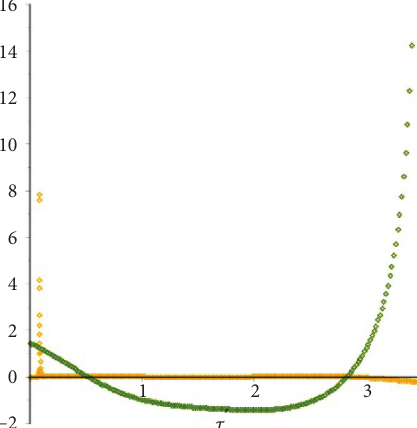
Figure 8: 2D with the differences between the real part of solutions obtained through the TEM and MTEM for fixed X � 0 . 062 and α � 0 .